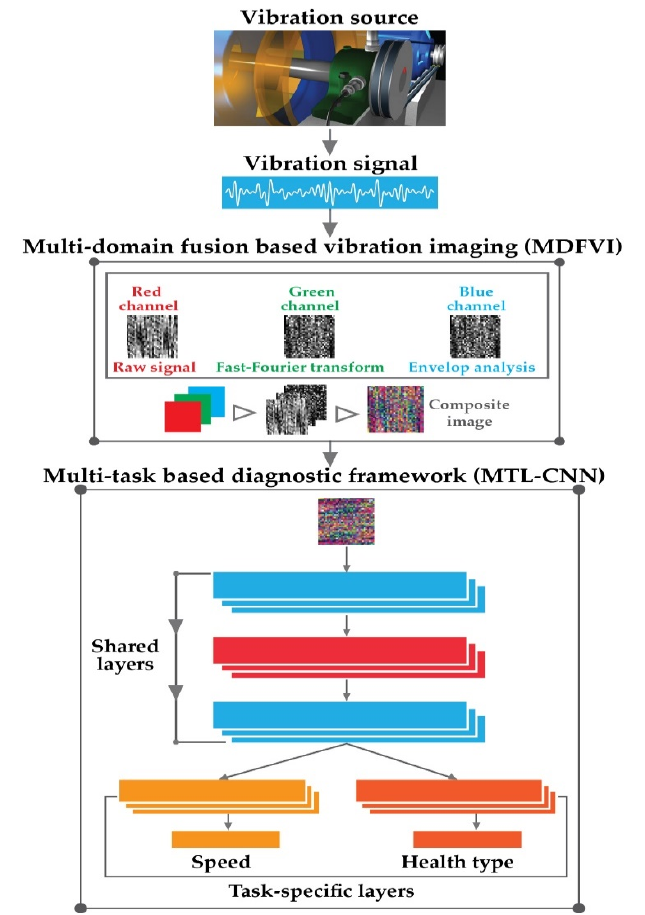
Figure 3. Proposed diagnostic framework.